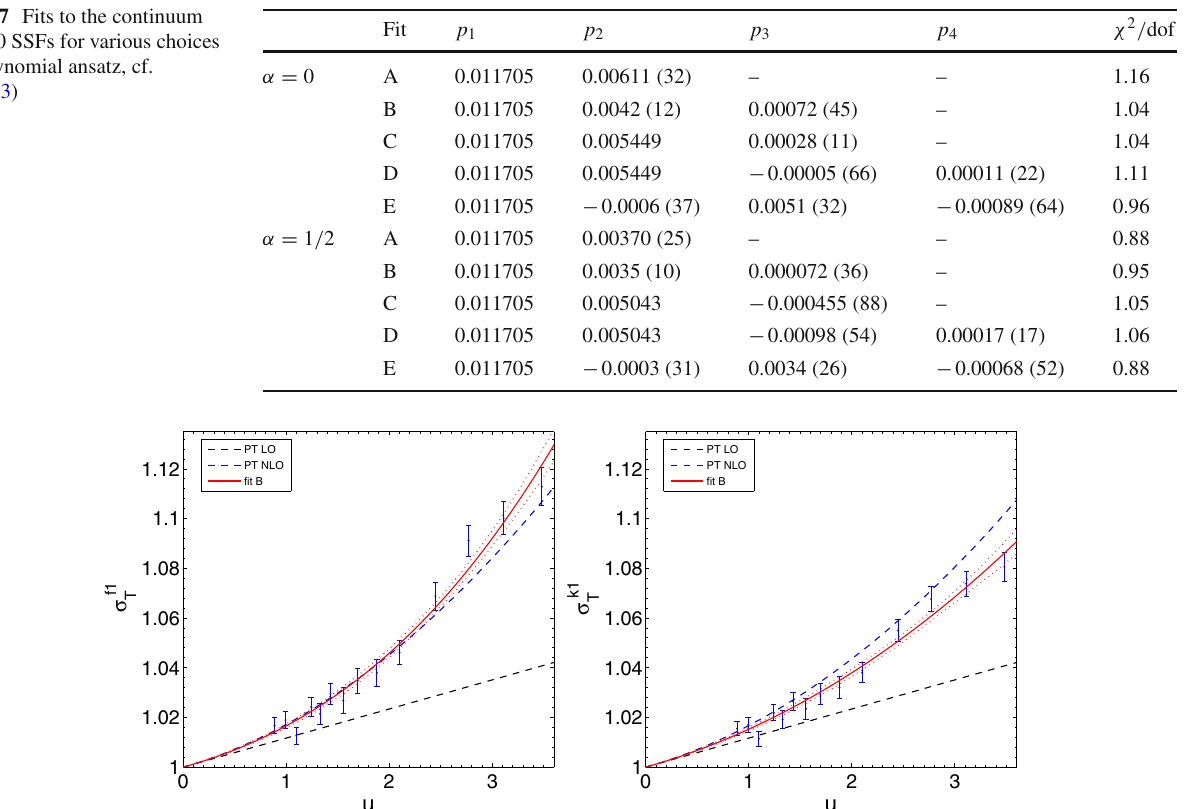
Fig. 5 N f = 0 continuum-extrapolated SSFs in the schemes α = 0 (left) and α = 1 / 2 (right), and their fitted functional forms following fit B in Table 7. The one- and two-loop perturbative predictions are also shown for comparison Table 8 Non-perturbative N f = 0 running in the scheme α = 0. (Our best result ˆ c 2 / 3 (μ ) is had